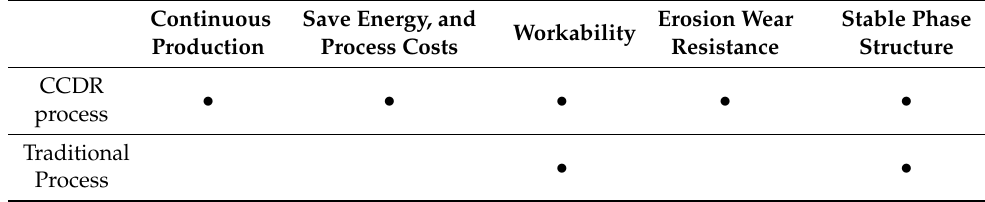
Table 4. Comparison of the material application properties ( • :